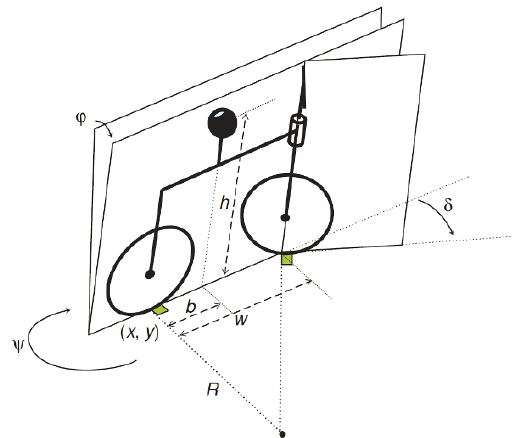
Figure 2. The inverted pendulum motorcycle